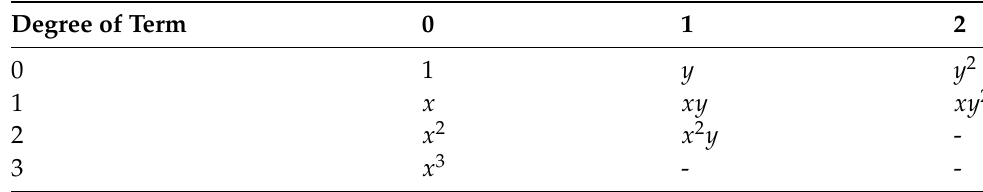
Table 3. Polynomial model